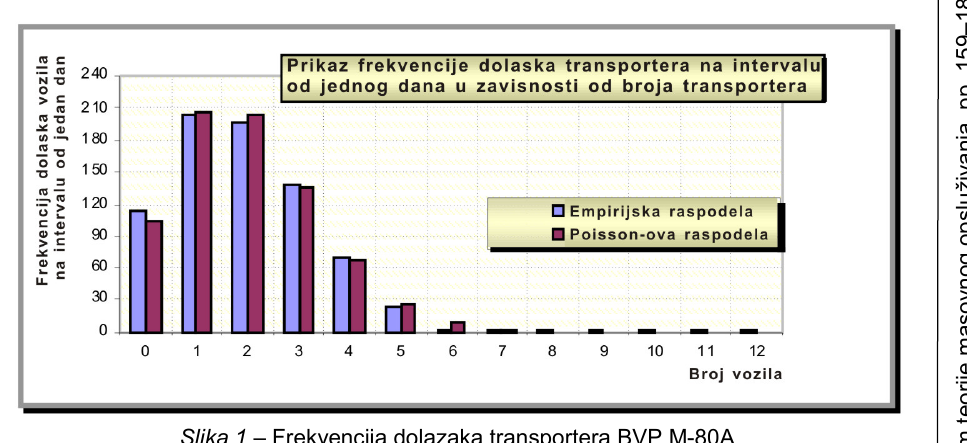
Prikaz frekvencije dolaska tenkova u intervalu od jednog dana dat je na slici 2.